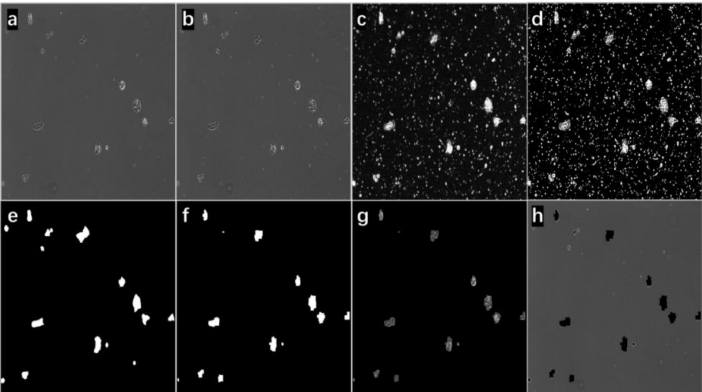
Figure 3. The cell image with low-density input. ( a ) The input image (from Input Image in Figure 1); ( b ) the sharpened image (from Sharpening and Resize in Figure 1); ( c ) the image contained all the edge information (from Grayscale Edge Image in Figure 1); ( d ) the edge image (from Otsu Binary Threshold in Figure 1); ( e ) the manually labeled binary image for comparison here; ( f ) the cell region binary mask; ( g ) the foreground image; ( h ) the background